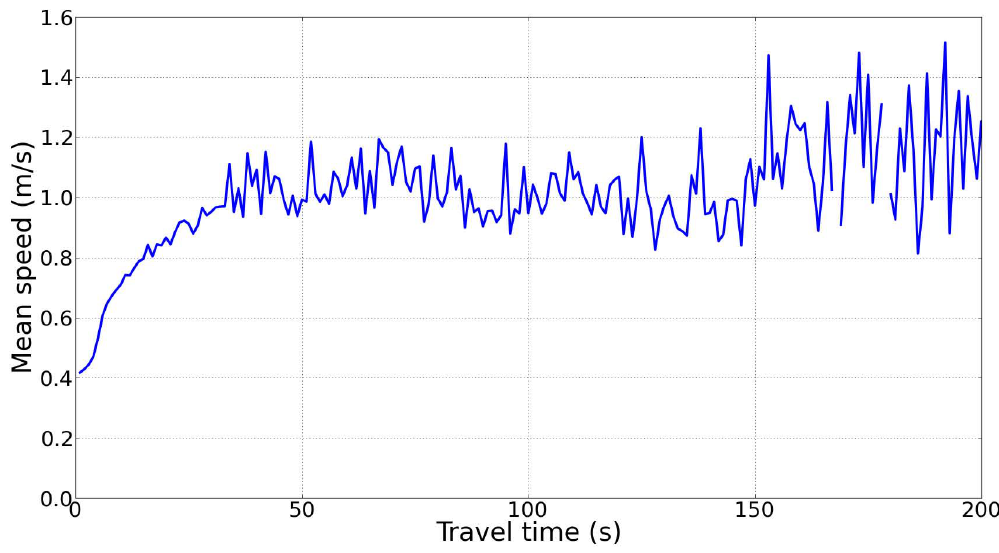
Figure 9. Mean speed as a function of travel time. Movement of duration shorter than 30 s occurs with lower speeds, which limits the increase of position errors when T 30